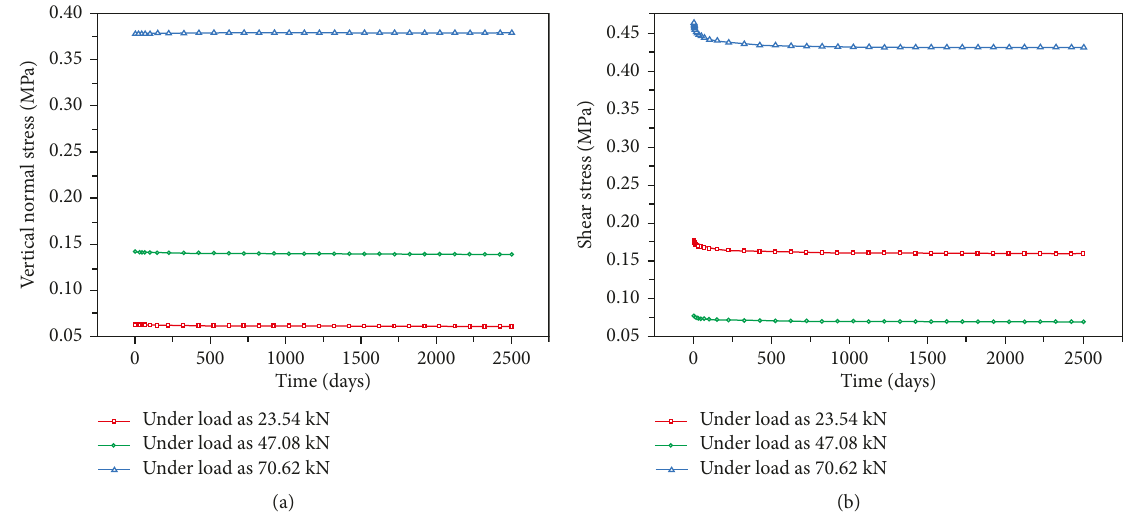
Figure 14: The separate effect of axial creep of adhesive on the edge stresses. (a) Variation of vertical normal stress with time. (b) Variation of shear stress with